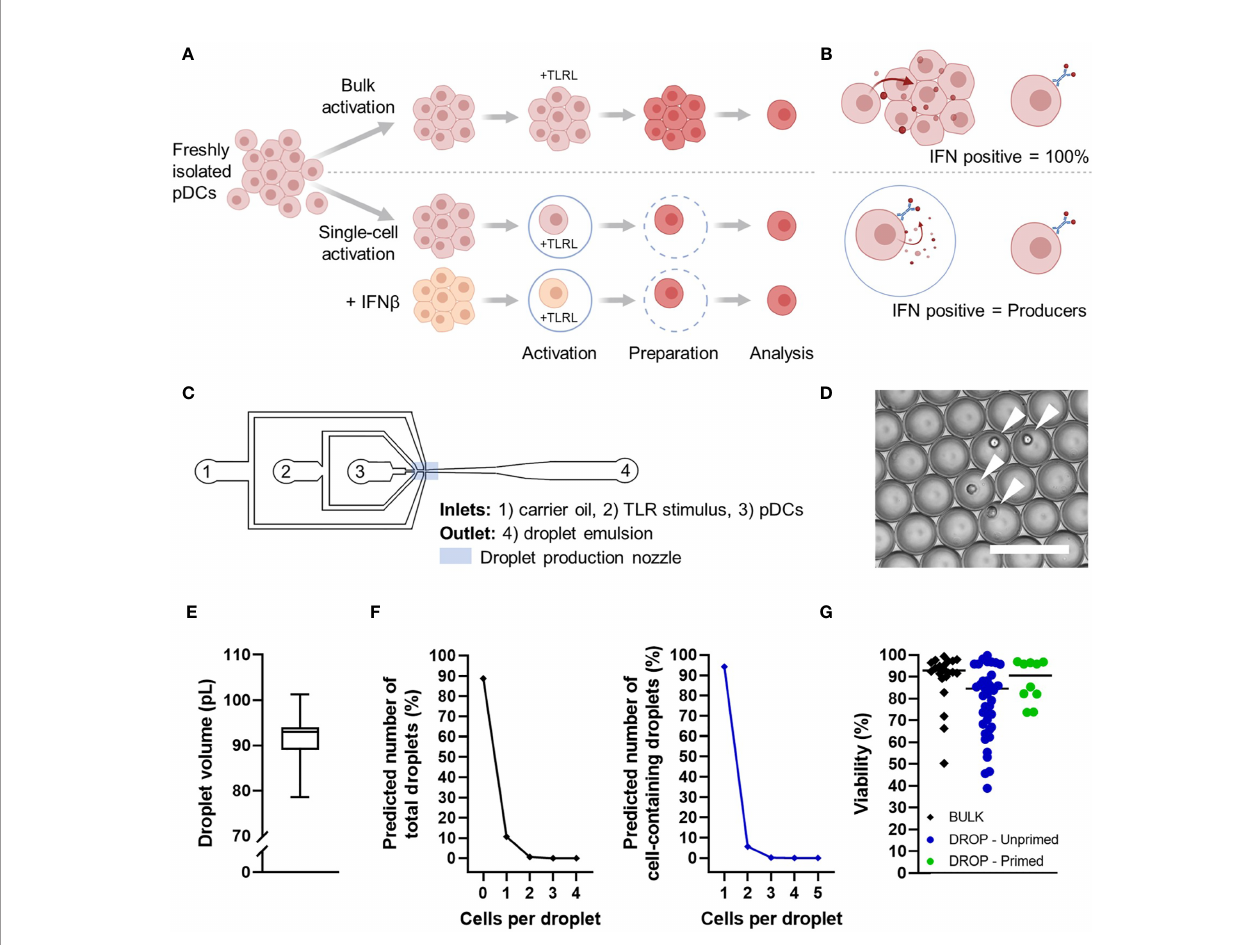
FIGURE 1 | Schematic overview of experimental conditions and micro fl uidic device. (A) Human pDCs were isolated from buffy coats, primed with 500 U/mL IFN b or left untreated. Next, all pDCs were coated with IFN a Catch Reagent and incubated with TLR ligands (TLRL) in bulk or droplets for 18 hours. Single cell encapsulation was achieved with concentrations of 1,300,000 cells/mL in 92 pL droplets on average. After incubation, encapsulated pDCs were retrieved from droplets by de- emulsi fi cation. Next, pDCs were washed thoroughly, fi xed and permeabilized, stained for viability, extracellular IFN a , surface marker expression, intracellular granzyme B, and analyzed by fl ow cytometry. (B) Schematic representation of IFN a production in bulk vs in droplets. (C) Schematic overview of micro fl uidic chip with inlets (1 – 3), outlet (4), and droplet production nozzle in blue rectangle. (D) Microscopic image of the droplet emulsion with single-encapsulated pDCs indicated with white arrows. Scale bar equals 100 m m. (E) Box plot depicting droplet volumes in pL, n = 100 droplets. (F) Theoretical fractions of total droplets (left) and cell- containing droplets (right) with x number of cells per droplet, according to the Poisson distribution, average droplet size of 92 pL, and cell concentration of 1,300,000 million cells/mL. (G) Viability of analyzed cells per experimental